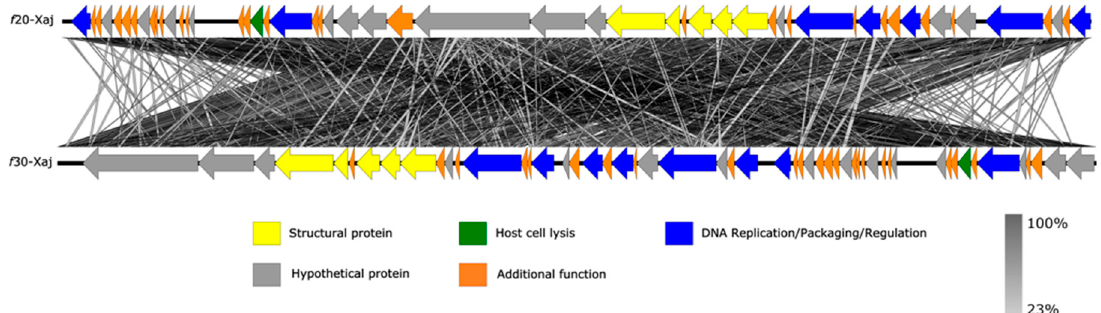
Figure 5. Schematic genomic alignment of f 20-Xaj and f 30-Xaj phage generated using the EasyFig program. Arrows with different colors represent ORFs according to their predicted functions indicated at the bottom. The grey bar in the lower right corner shows the identity percentage associated with the color of the bars connecting homologous regions.